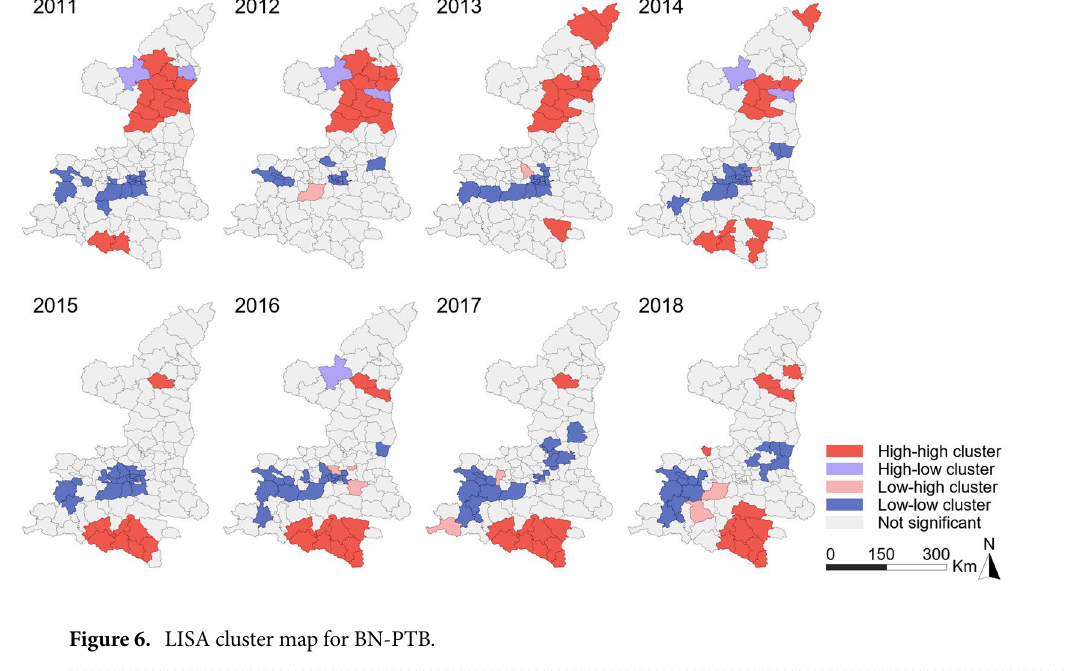
Figure 6. LISA cluster map for BN-PTB.